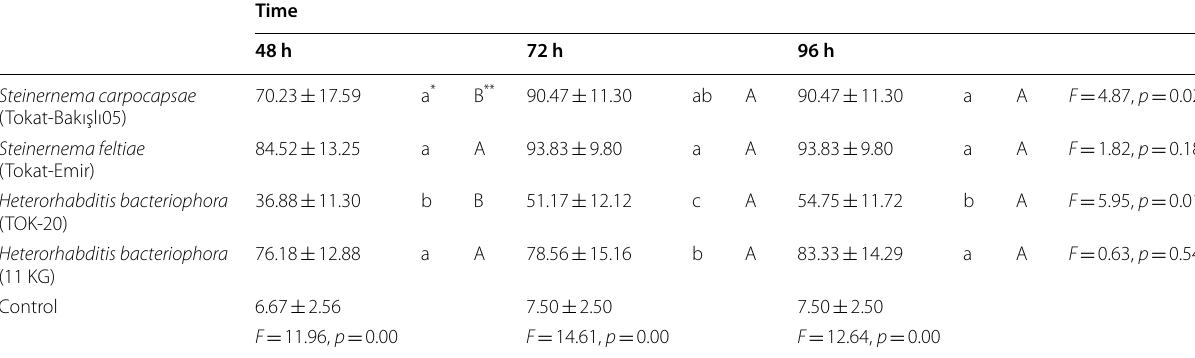
* Means within column bearing the same letter are not significantly different (Duncan’s test, p > 0.05) ** Means within lines bearing the same letter are not significantly different (Duncan’s test, p > 0.05)